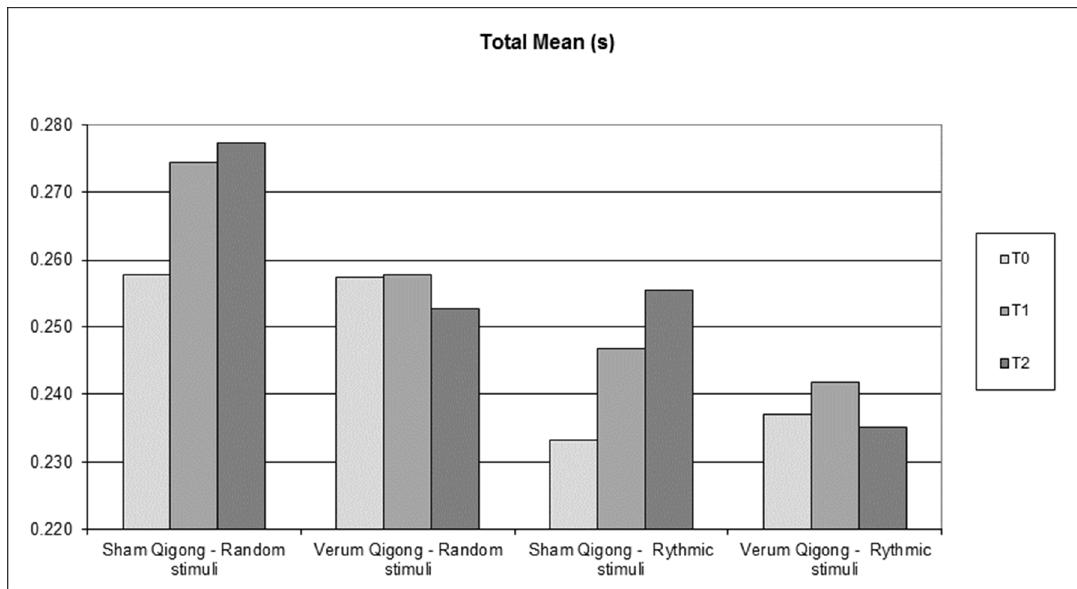
Figure 1. Stimuli mean results at each assessment time for both groups.